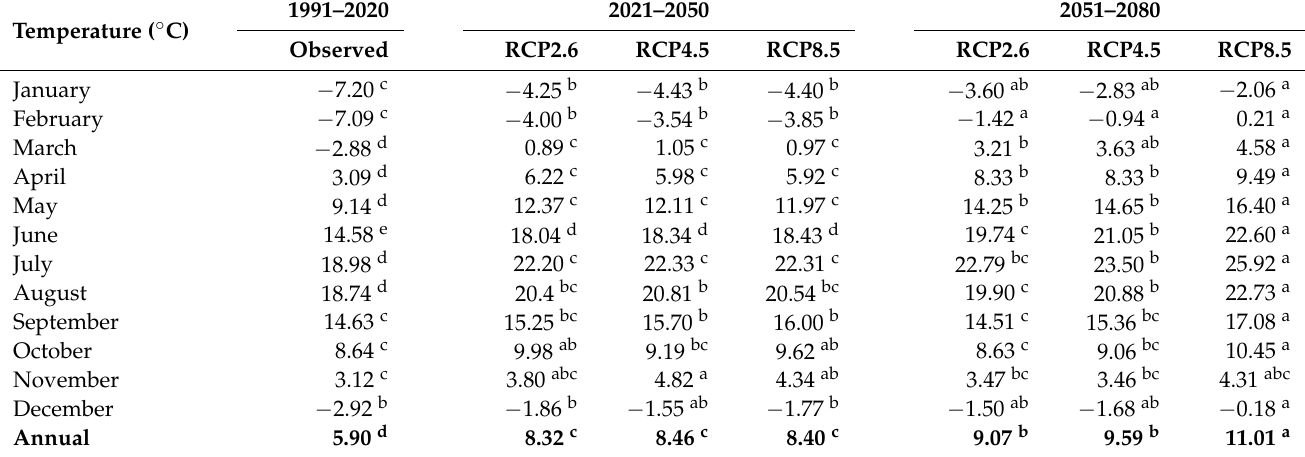
Note: Means that do not share a letter are significantly different at α = 0.05 (95% confidence) as per Tukey’s method. The bolded values represent annual average of all the